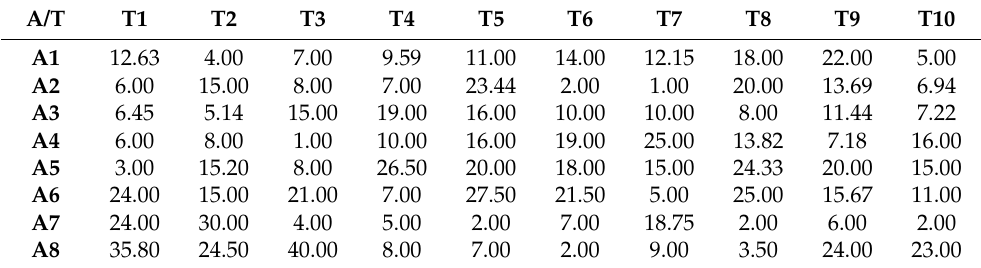
Table 4. Hurwicz and Bayes (H + B)